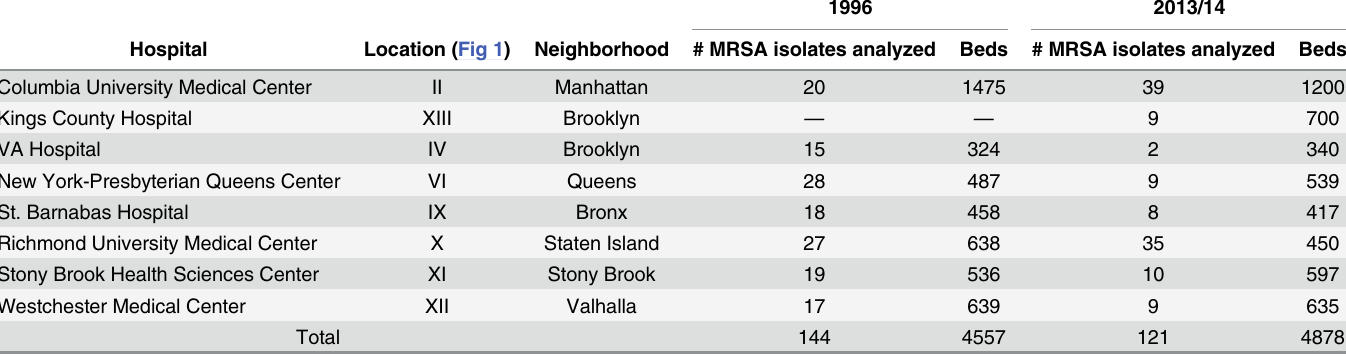
Table 1. MRSA specimens provided by the participating